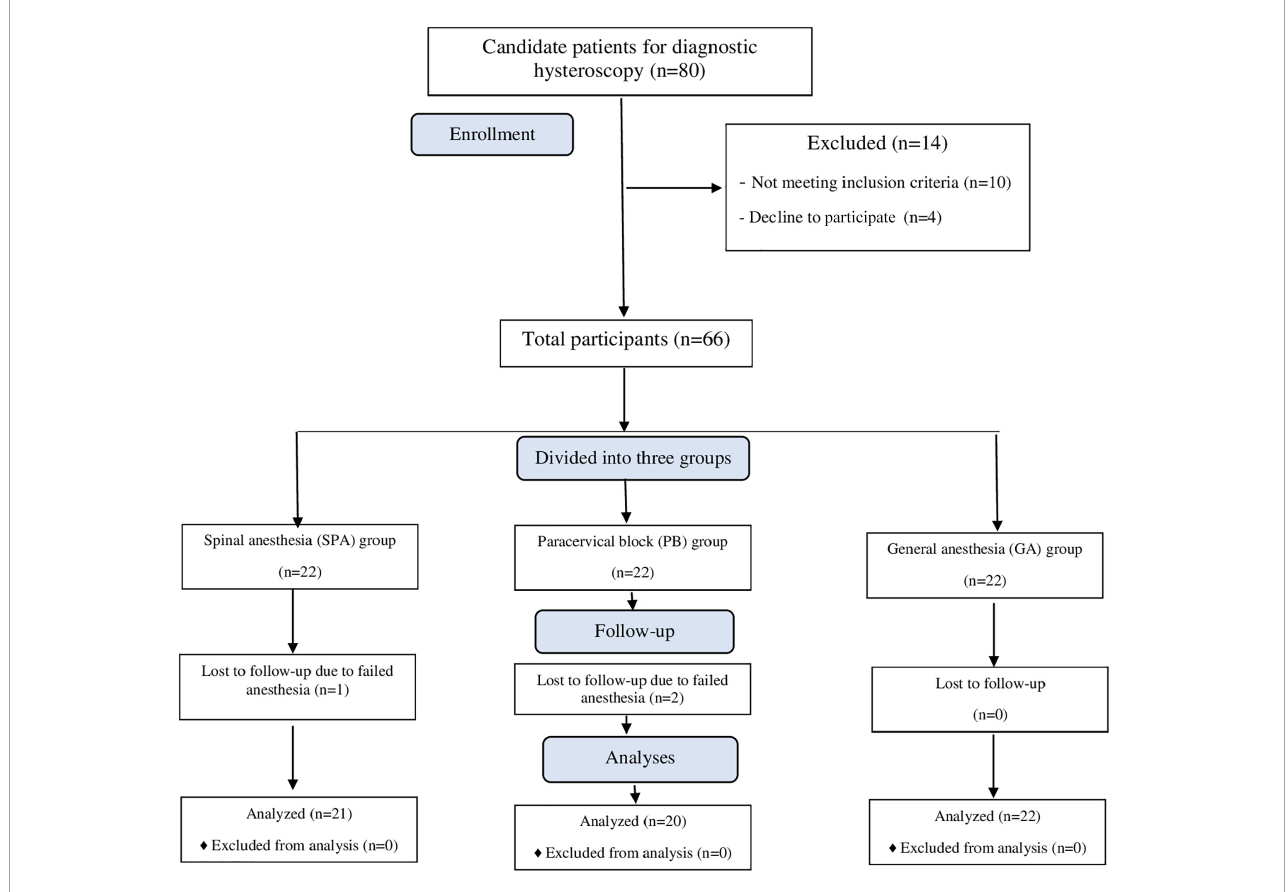
FIGURE1 The CONSORT flow chart of study population.